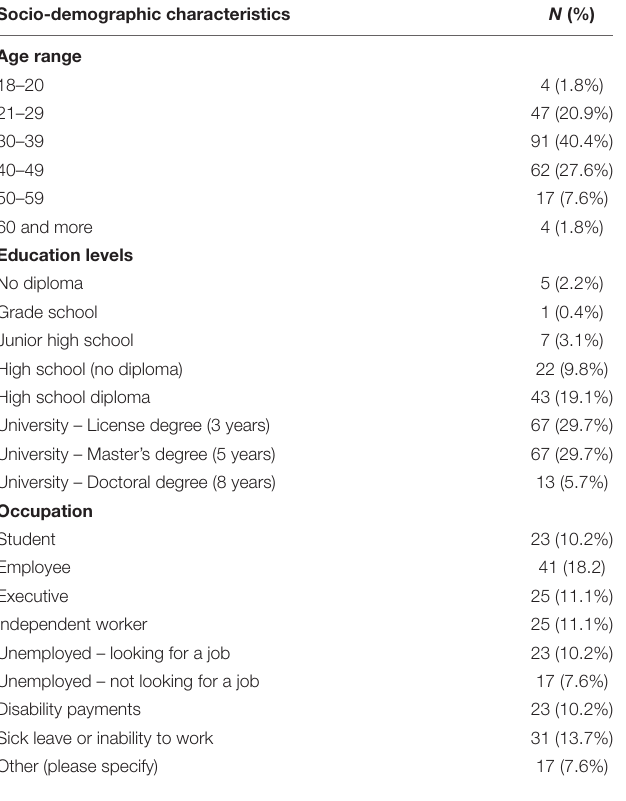
TABLE 1 | Socio-demographic characteristics of participants.